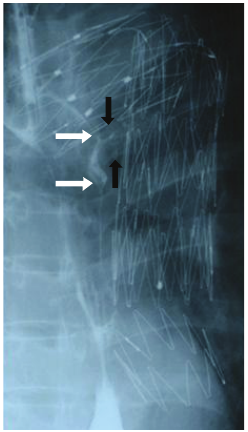
Figure 2: Esophagography revealed an elevated lesion (white arrows) and a fistulous tract toward the stent graft (black arrows).